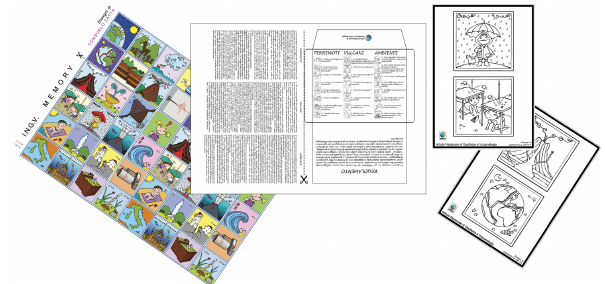
Figure 4. INGV-memory kit game. The kit includes 48 cut-out cards, the corresponding questions and answers, and the colouring sheets (illustration made by Consuelo Zatta).